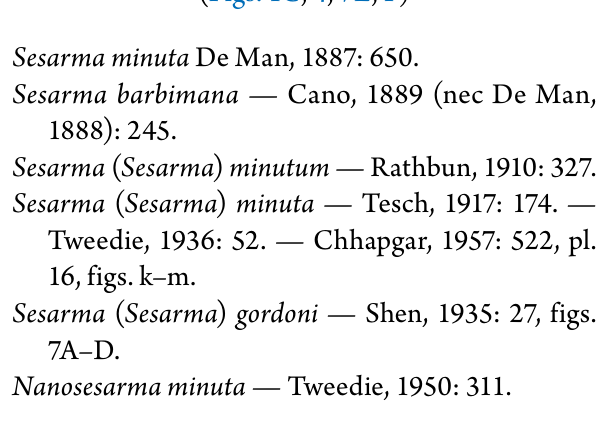
than long; lateral margins almost straight, gradually diverging posteriorly; dorsal surface, strongly